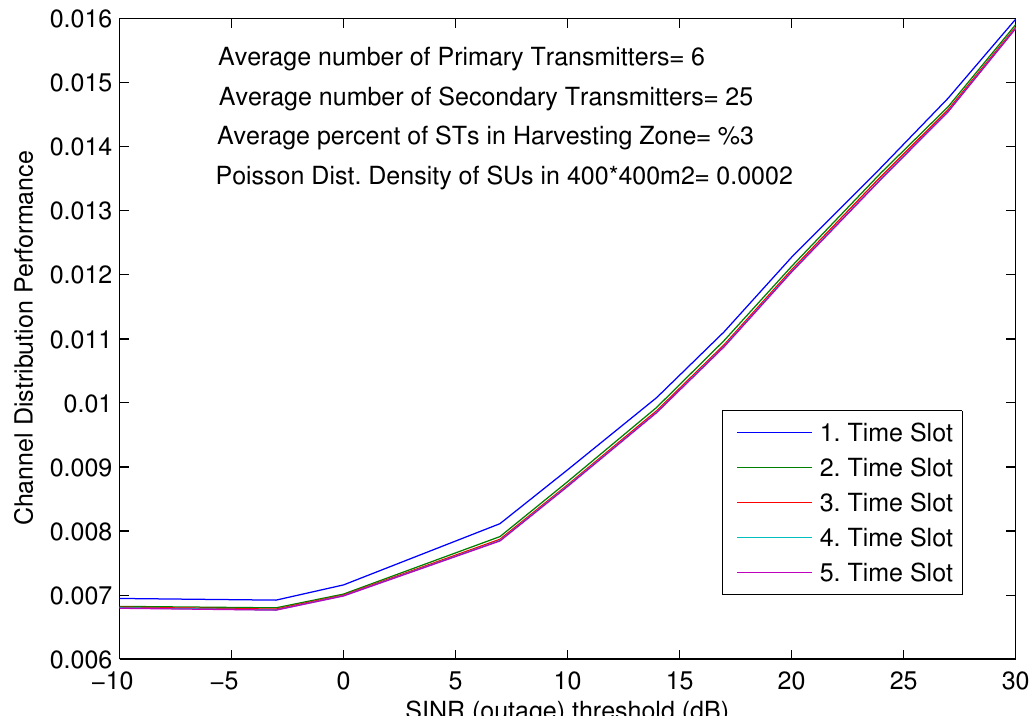
Figure 7. ChDistFairness against different SINR (threshold) values for Poisson distribution density of STs of 0.0002 on the area of 400 × 400 m 2 around the PT and average percentage of STs in the harvesting zone of about